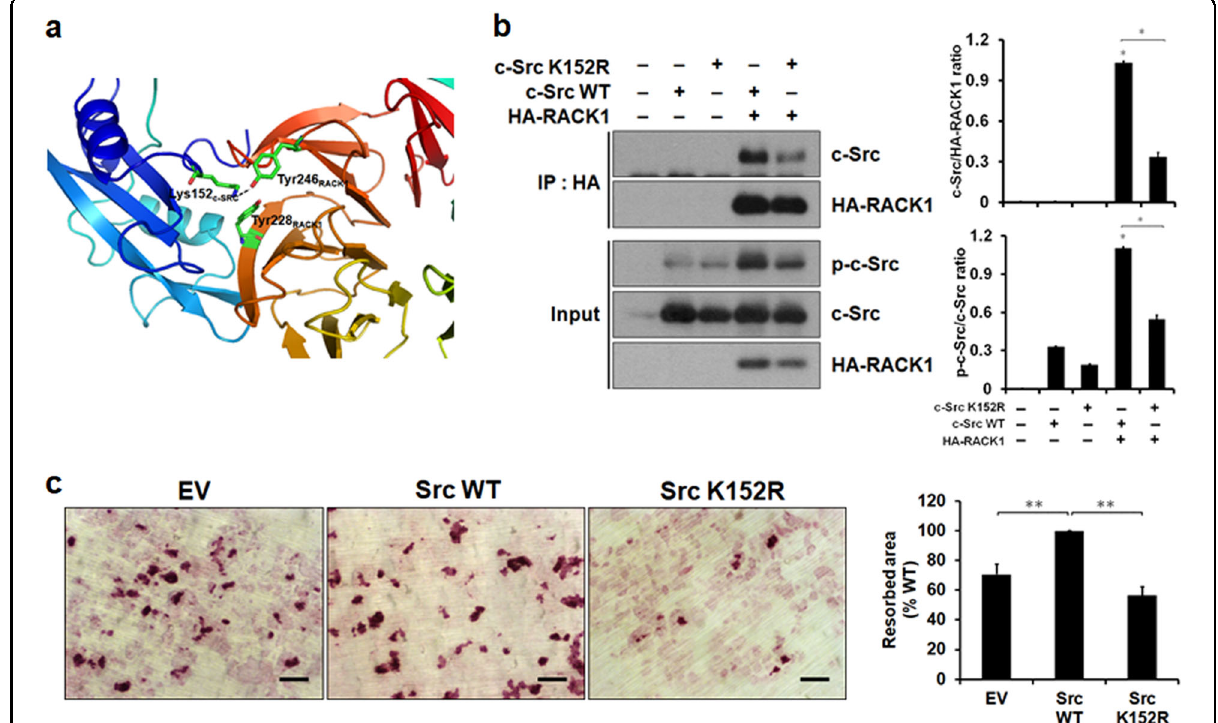
Fig. 4 c-Src K152R mutation affects osteoclastic bone resorption. a Model of the interaction between the SH2 domain of c-Src and RACK1. Key interacting residues were rendered as a space- fi lling structure. b First, 293T cells were transfected with the indicated expression vectors. RACK1 was immunoprecipitated from cell lysates using anti-HA. The precipitated complexes and cell lysates were analyzed using western blotting. The ratios of c-Src to HA-RACK1 and p-c-Src to c-Src were quanti fi ed in each of three independent experiments. * P < 0.01. c BMMs transduced with pMX-puro empty vector (EV), pMX-puro-WT-c-Src (Src WT), or pMX-puro-K152R-c-Src (Src K152R) were cultured for 3 days with 30 ng/mL M-CSF and 100 ng/mL RANKL to generate mature osteoclasts. Mature osteoclasts were seeded on bone slices and cultured for 3 days. The cells were then removed, and the bone slices were stained. Scale bar, 50 μ m. Right: images of the stained sections were used to calculate the resorption pit areas. Data are presented as the mean ± SD of three independent experiments. * P < 0.01, ** P <